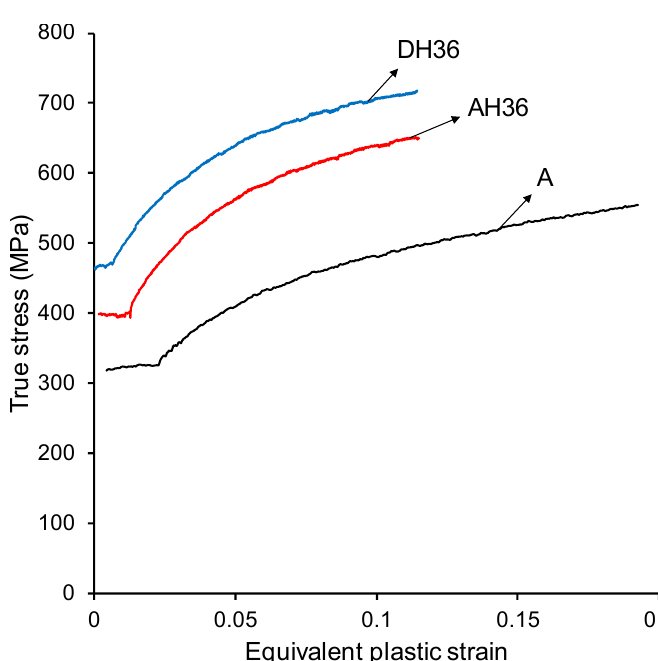
Figure 8. Experimentally obtained true stress-equivalent plastic strain